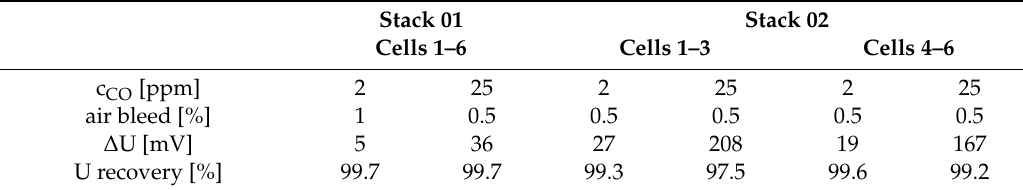
Table 1. Summary of Average Cell Voltage Loss of Stack 01 and Stack 02 at Di ff erent CO